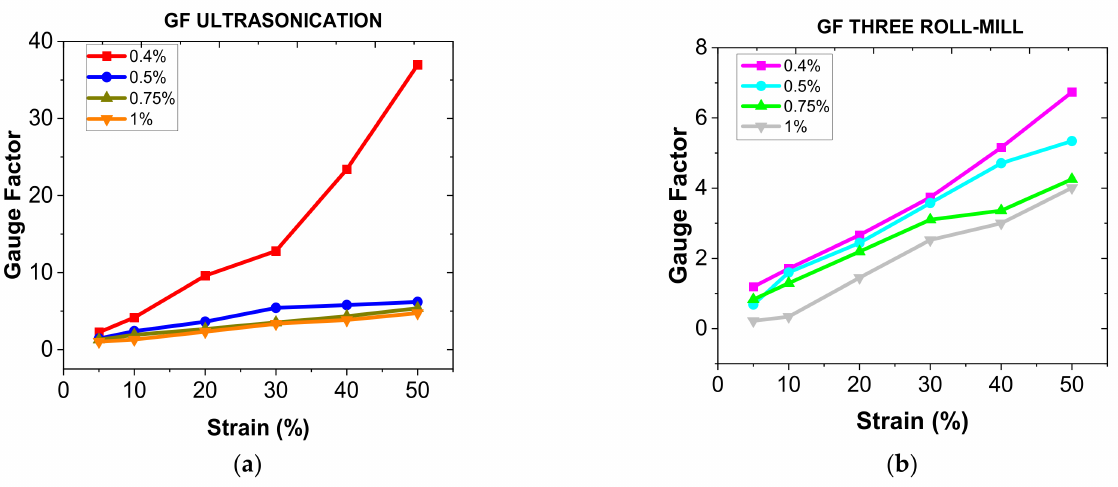
Figure 6. GF values obtained for ( a ) US and ( b ) 3RM CNT dispersion routes as a function of CNT